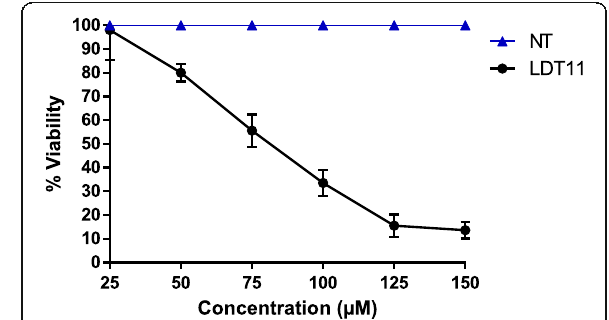
Fig. 3 Cell viability by the WST-8 method in RAW264.7 cell line, using different concentrations of the phenolic acid derivative LDT11. NT - untreated cells. LDT11 - cells treated with LDT11 and then with LPS